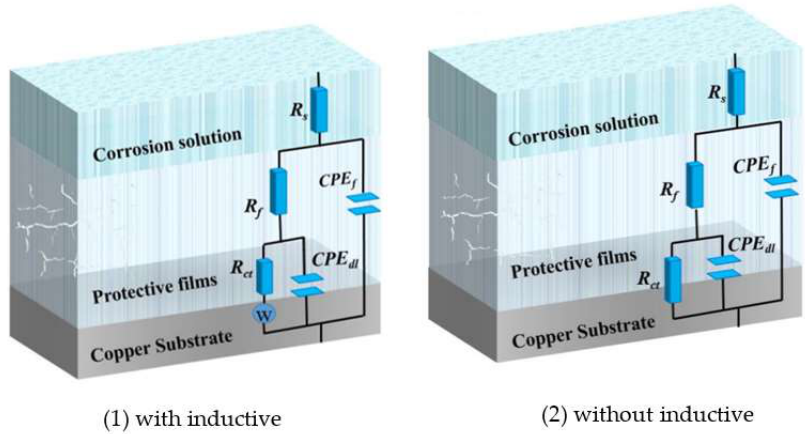
Figure 3. The equivalent circuits with and without inductive.